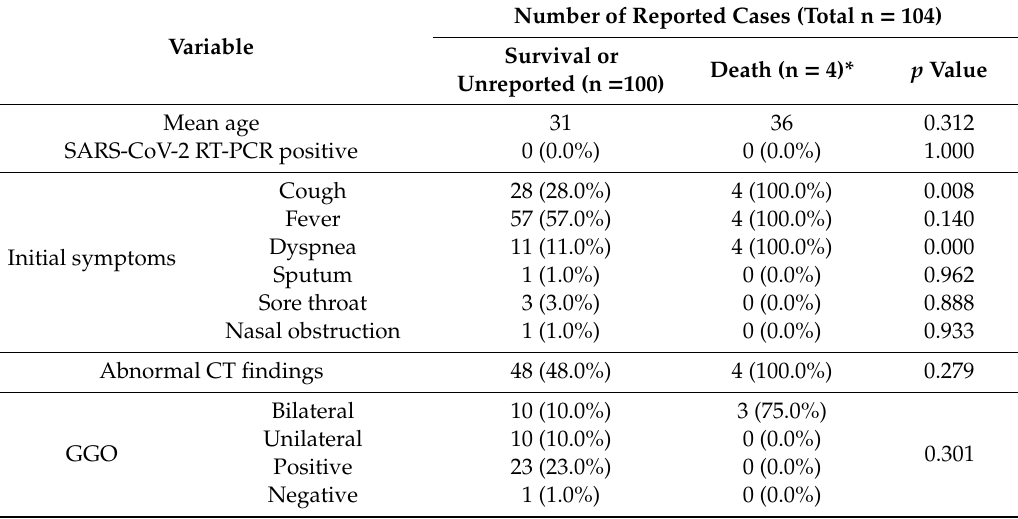
Table 9. Evaluation of clinical characteristics on fetal